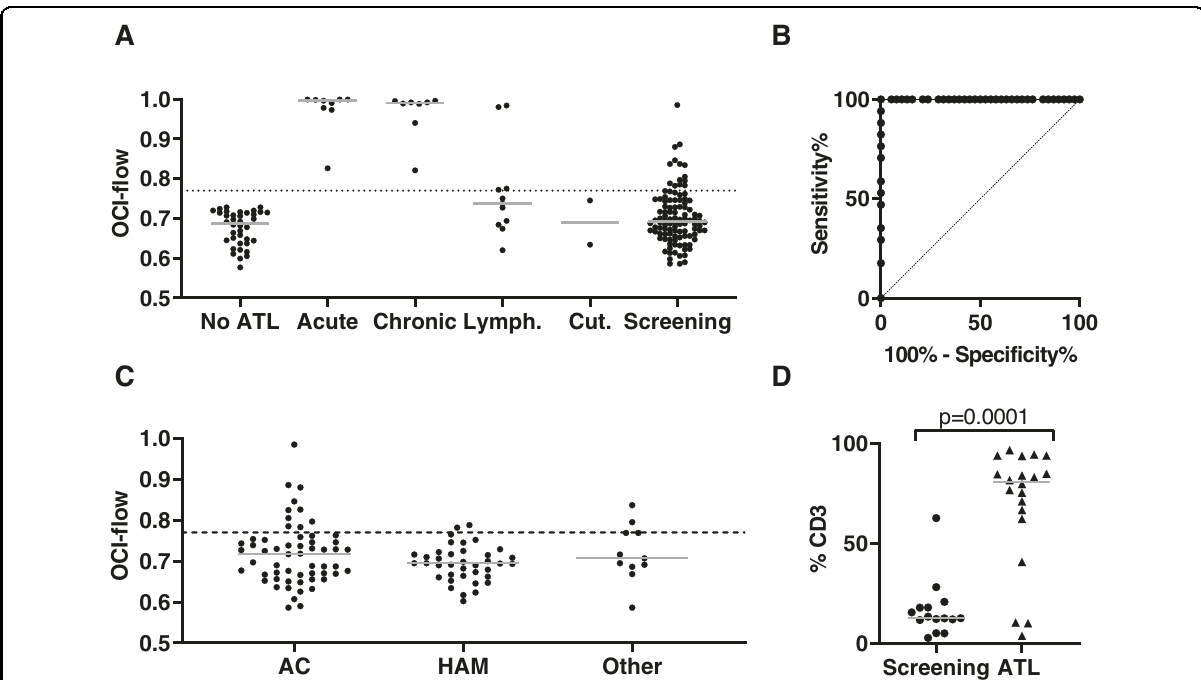
Fig. 1 OCI- fl ow score and frequency of ATL-like clones. a OCI- fl ow scores of samples from the No-ATL ( n = 38), ATL ( n = 30) and screening cohorts ( n = 106). Flow cytometric analysis was performed on PBMCs stained with a viability stain and antibodies speci fi c for 24 TCRV β subunits and T cell lineage markers. As there was no signi fi cant difference in the OCI- fl ow of treated vs untreated ATL patients in this cohort (Mann – Whitney test, p = 0.22) all ATL subjects have been included in this fi gure, regardless of whether they were on treatment or not. Lymph, lymphoma; Cut., cutaneous type ATL. Samples from patients with cutaneous subtype ATL were not included in the statistical analysis due to the low number of cases ( n = 2). b Receiver-operating characteristic (ROC) curve of the ATL cohort and the no ATL cohort. Only ATL patients with blood disease (acute/chronic subtype ATL) were included. c OCI- fl ow of HTLV-1 carriers in the screening cohort by HTLV-1-related disease status. Subjects in the screening cohort were grouped into AC, HAM or HIV-coinfected (HIV) or ‘ Other HTLV-associated diseases ’ (Other) for statistical purposes (see Table 1). Statistical analysis: Kruskal – Wallis test. d Frequency of ATL-like and malignant clones within PBMC. The frequency of a given CCR4 + CD26 − TCRV β X + population was expressed as a percentage of total CD3 + cells in samples with OCI- fl ow >0.770. In the Screening cohort, n = 15 as three subjects have two populations of cells meeting our criteria or de fi nition of a clone and two subjects had no clone meeting our criteria. In the ATL cohort, n = 20 as one subject had two populations meeting our de fi nition of a clone. Statistical analysis: Mann Whitney, two- tailed. In all graphs, a grey line indicates the